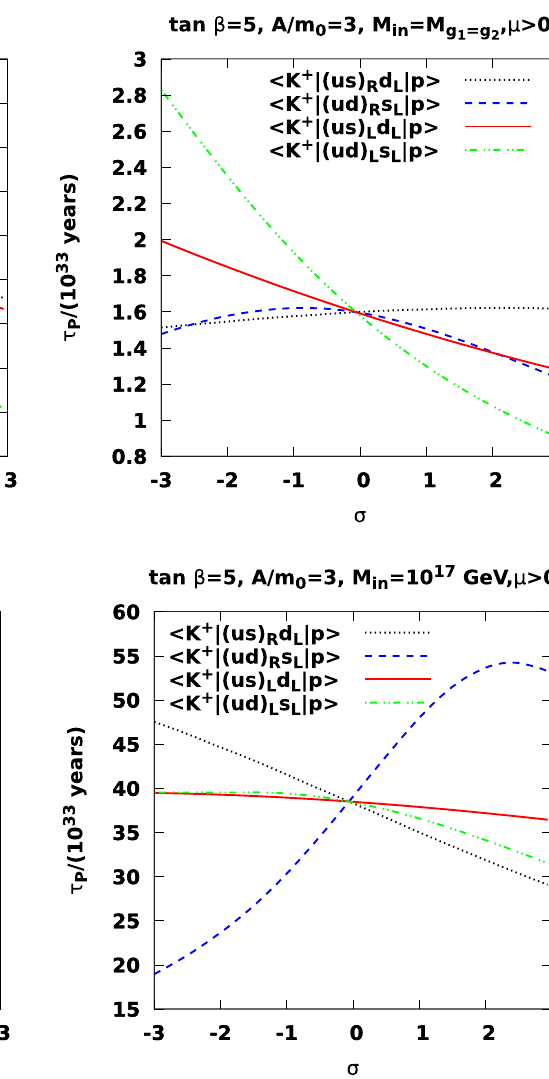
( m 0 , M in ) = (14.13, M GUT ) (upper left); (10, M GUT ) (upper right); (14.13, M GUT ), with c (cid:15)= 0 (lower left); (15.45, 10 17 GeV)